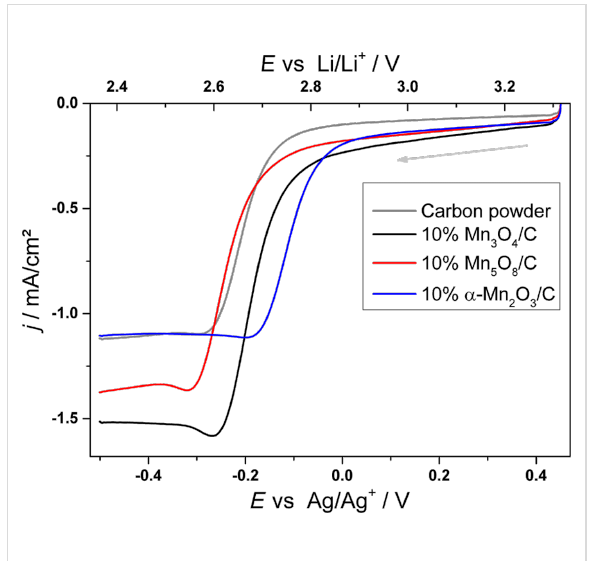
Figure 9: Linear sweep voltammograms of pure carbon powder (grey), Mn 3 O 4 /C (black), Mn 5 O 8 /C (red) and α -Mn 2 O 3 /C (blue) electrodes;